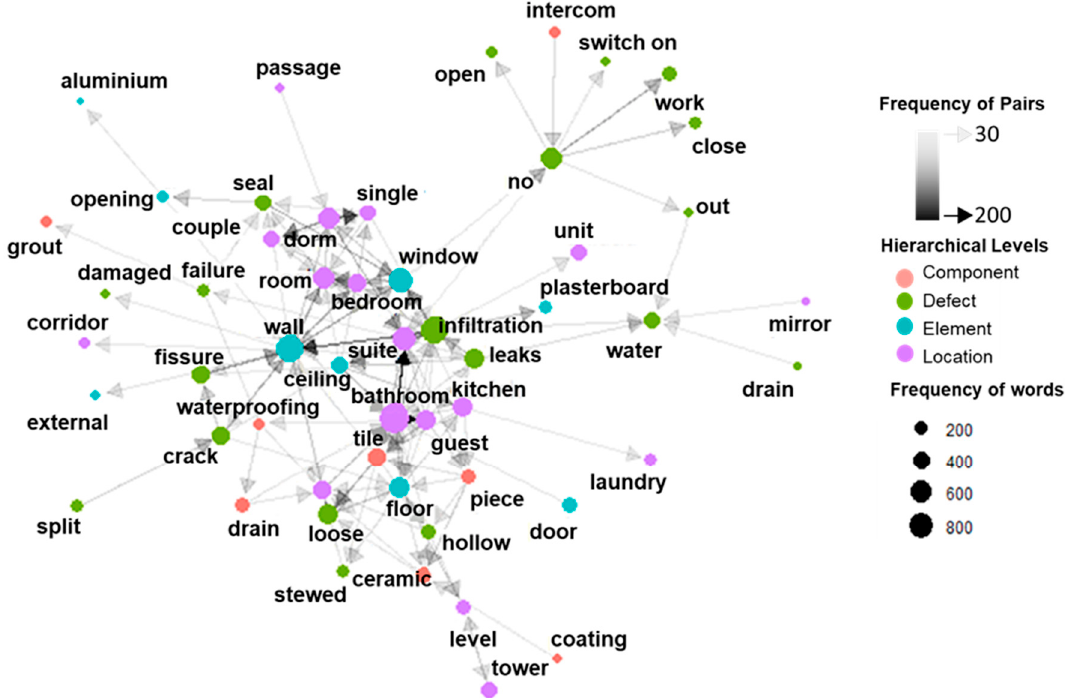
Figure 2. Relationships between